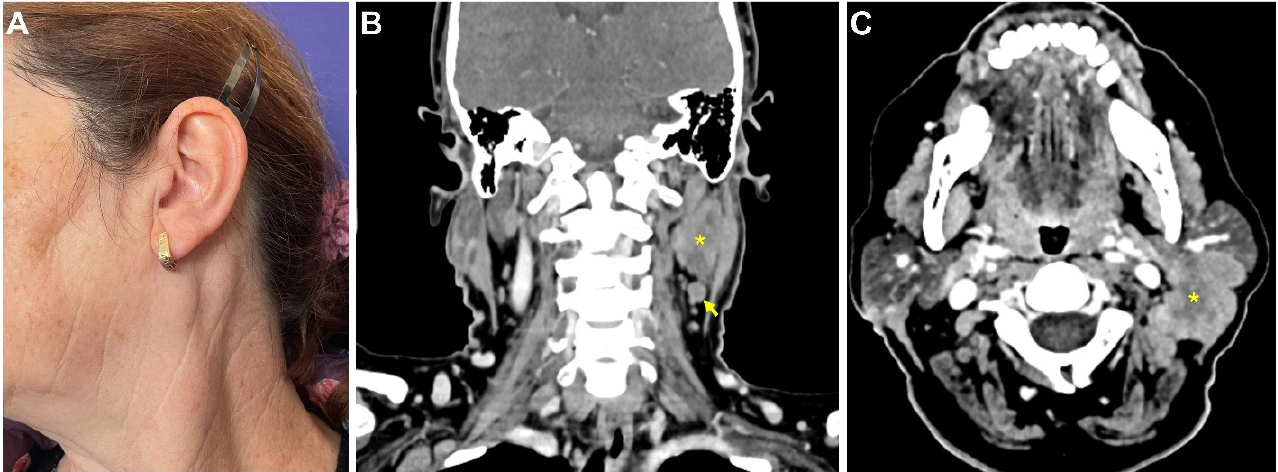
Figure 1. Clinical and imaging aspects at presentation. Clinical aspect ( A ). Contrast-enhanced CT scan of the neck in the coronal ( B ) and axial ( C ) planes. Large necrotic tumor (*) located on the posterior and inferior aspect of the left parotid gland, with infiltration of the adjacent muscles and enlarged regional lymph nodes (arrow).